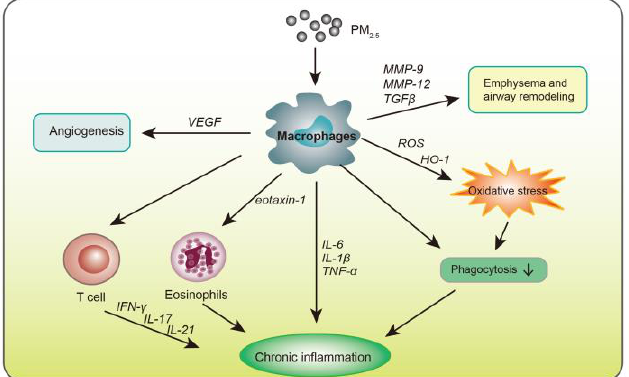
Figure 1. The role of macrophages in PM 2.5 -related chronic airway diseases. PM 2.5 exposure promotes recruitment of macrophages and release of cytokines, such as IL-6, IL-1 β , and TNF- α . Macrophages also release eotaxin-1 to attract eosinophil recruitment, and stimulate T cells to produce IFN- γ , IL-17, and IL-21. PM 2.5 induces macrophage phagocytosis dysfunction, which is related to oxidative stress. Above effects leads to chronic lung inflammation. The increased expressions of ROS and HO-1 in macrophages aggravates pulmonary oxidative stress. MMPs and TGF- β released by macrophages are involved in the process of emphysema and airway remodeling. In addition, macrophages involved in tumor angiogenesis by releasing VEGF.